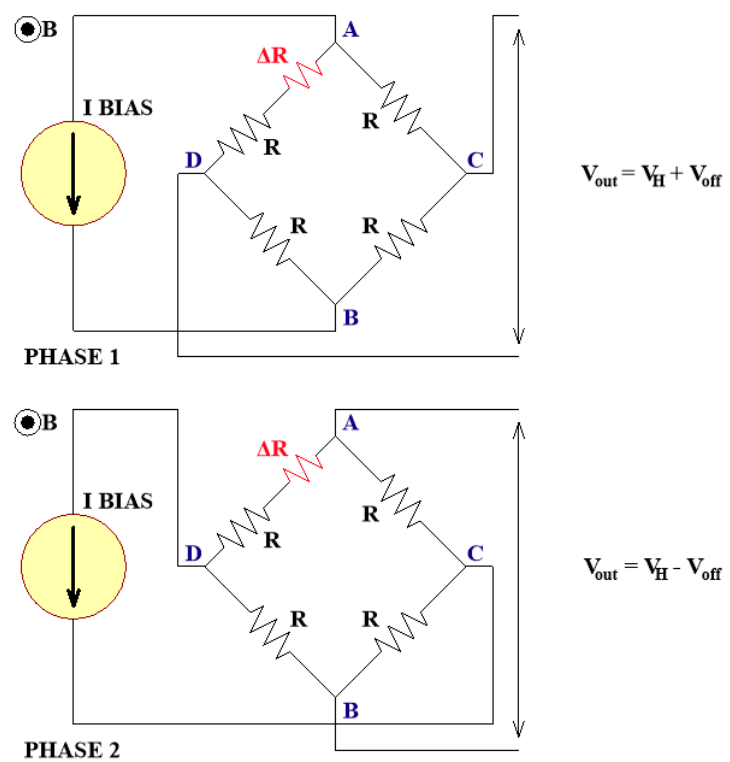
Figure 2. Spinning Current Technique showing two phases. In phase 1 the current flows from terminal A to B and voltage is sensed between C and D, while in phase 2 the terminals are swapped and the offset voltage changes polarity.